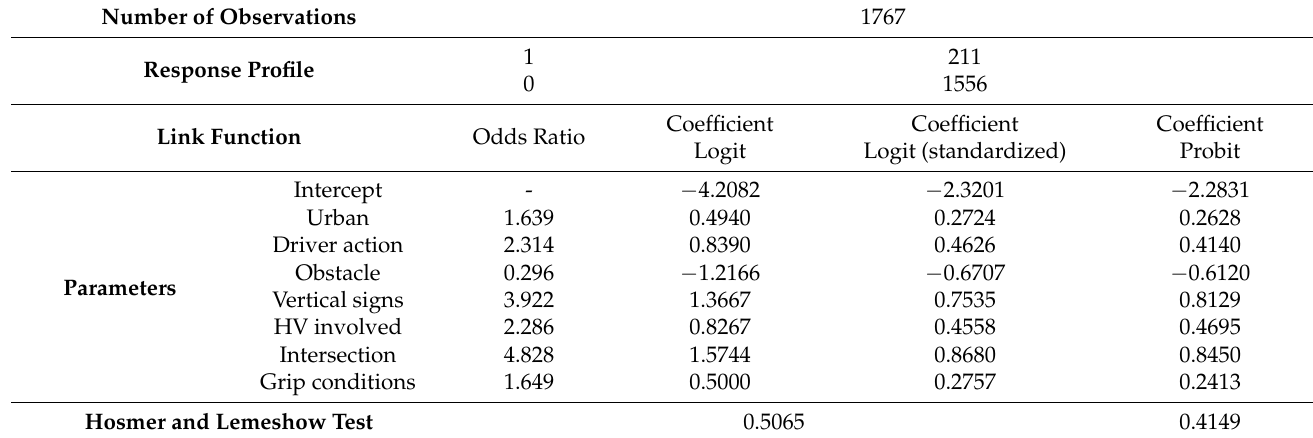
Table 4. Estimated coefficients and odds for angle crash